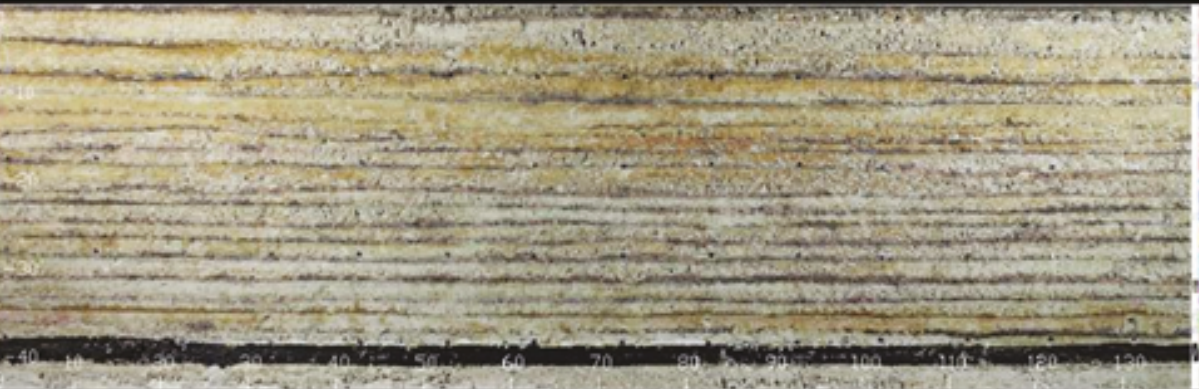
Figure 8: Simulation experiment model.